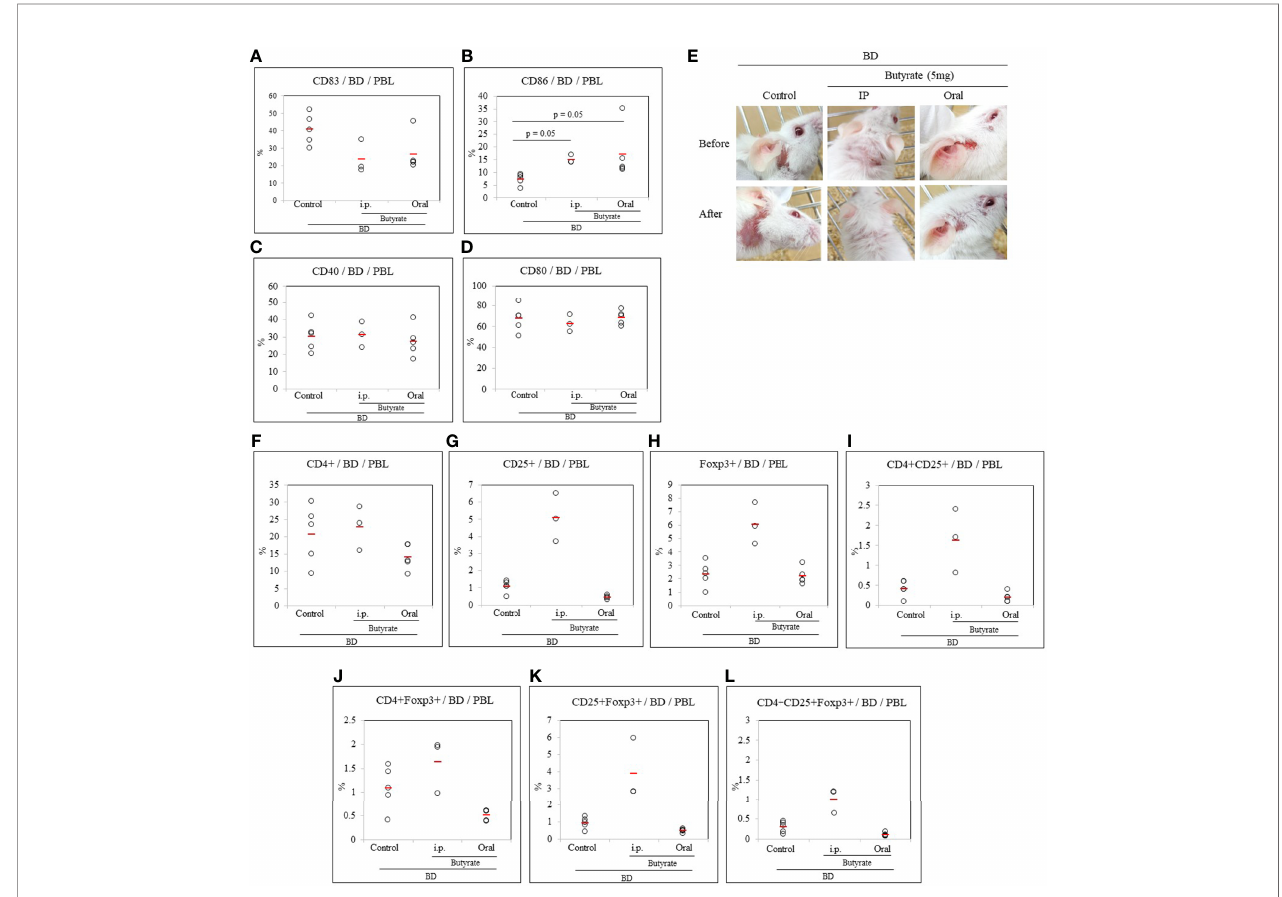
FIGURE 5 | Butyrate affected the frequency of CD83+ cells in BD mice. In BD mice treated with butyrate, the frequency of DC co-stimulatory molecules CD83, CD86, CD40, and CD80 was evaluated by fl ow cytometric analysis of PBL surface staining (A – D) . The intraperitoneal or oral administration of butyrate to BD mice decreased the frequency of CD83+ cells (B) and signi fi cantly increased the frequency of CD86+ cells (D) . Butyrate treatment improved the symptoms in BD mice (E) . The frequency of regulatory T cells was analyzed by FACS after the intraperitoneal or oral administration of butyrate to BD mice (F – L) . The p-value was determined by the Kruskal-Wallis test. The experiments were performed independently at least three